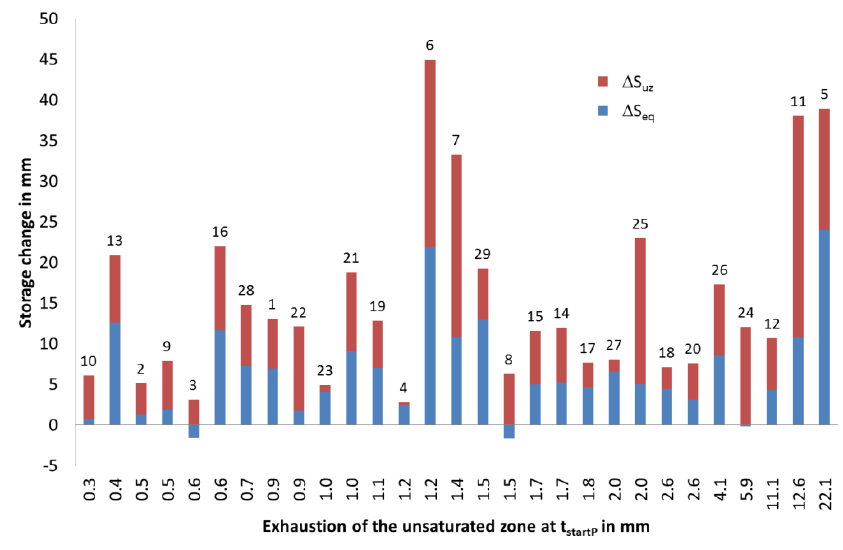
Figure 7. Separation of ∆ S into ∆ S eq and ∆ S uz for the rainfall events (event ID above bar).